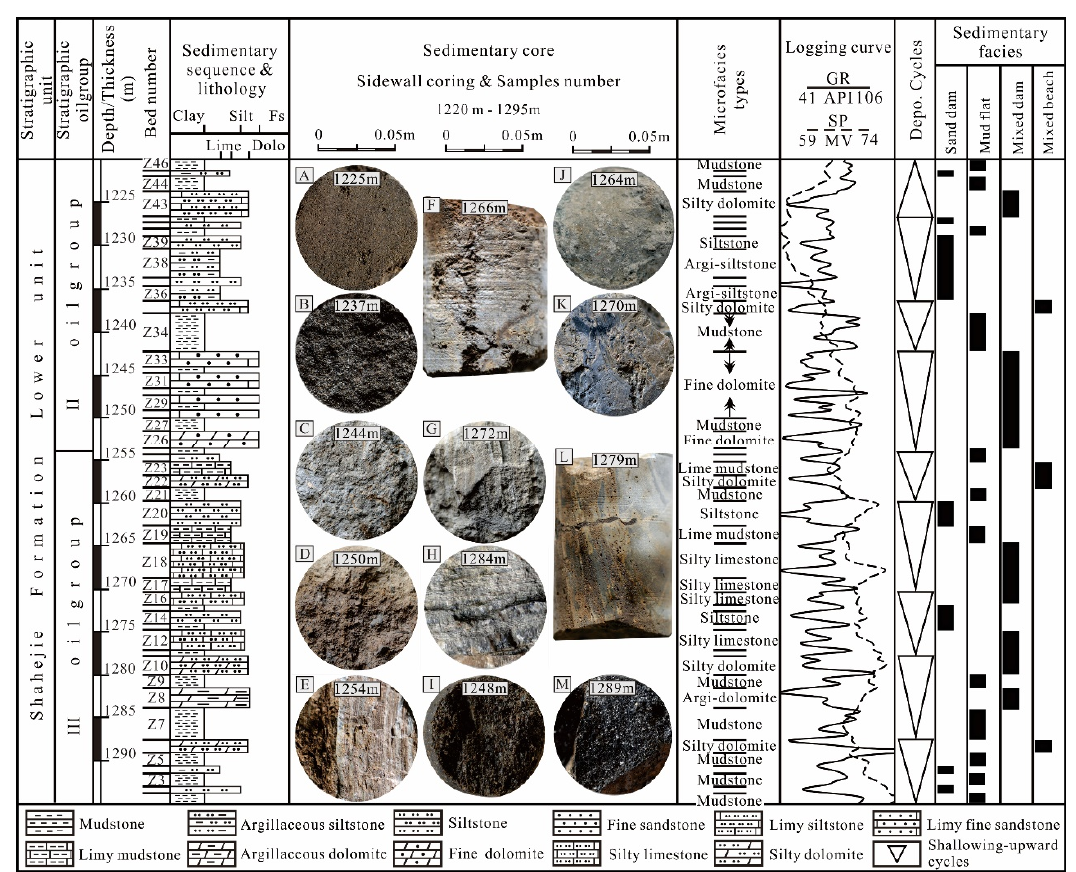
Figure 2. The stratigraphic units, logging, and sedimentary characteristics of the selected research area.